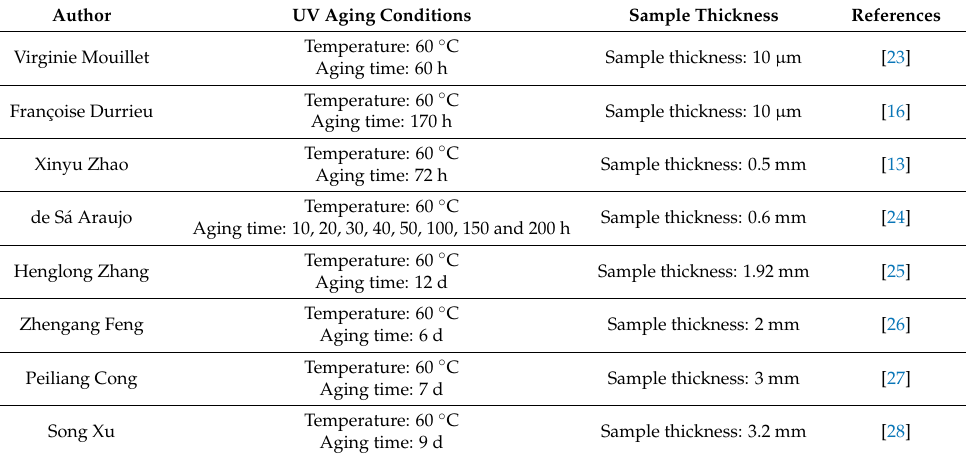
Table 1. UV aging conditions and sample thicknesses of previous research.